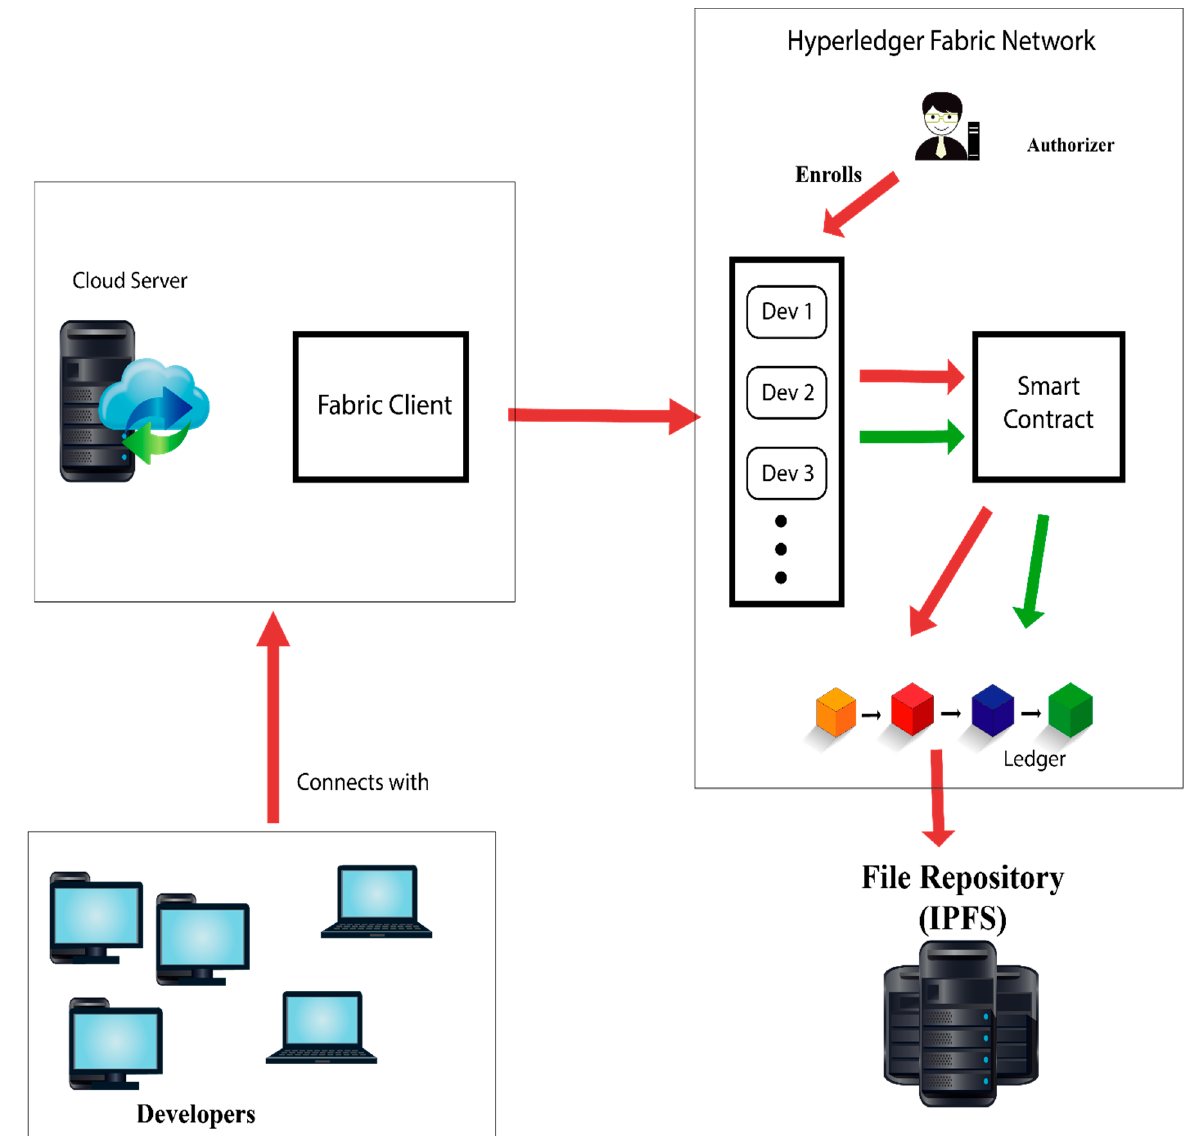
Figure 8. Implementation model for BDA-SCV.